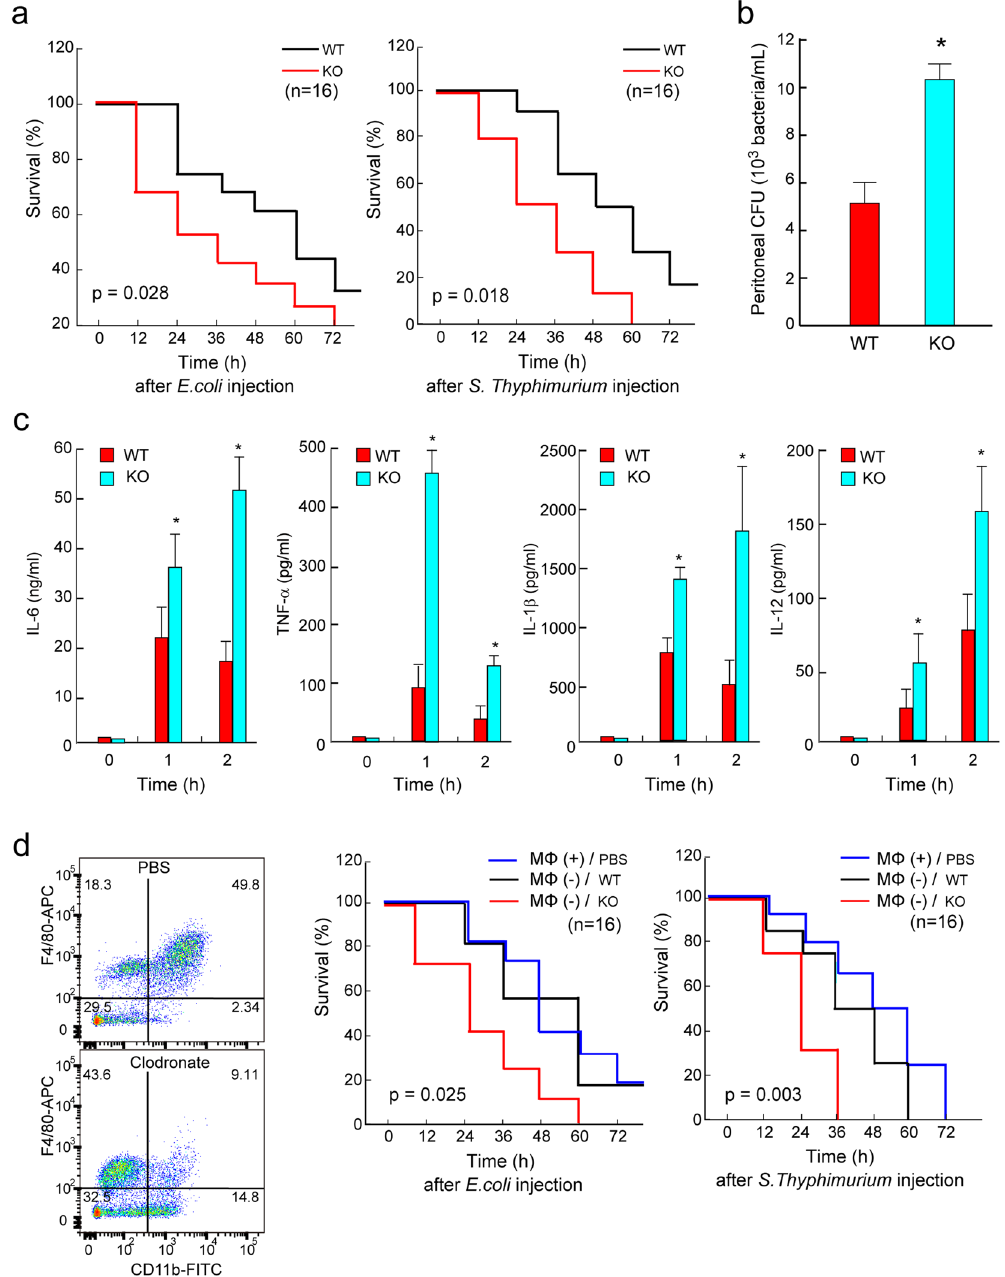
Figure 6. TAGLN2 participates in host survival after bacterial peritonitis. ( a ) TAGLN2 − / − mice demonstrate reduced survival after bacterial peritoneal sepsis. Age-, sex-, and weight-matched wild-type (black line) and TAGLN2 − / − (red line) mice were injected i.p. with 5 × 10 8 CFU of live E. coli (DH5 α ) or 5 × 10 6 CFU of live S. typhimurium . Kaplan-Meier survival curves revealing the proportion of mice that are alive in each group as a function of time from the first injection of bacteria are shown. ( b ) The E. coli cell count in peritoneal lavage fluid from wild-type or TAGLN2 − / − mice 4 h after i.p. administration of 10 8 CFU/mouse of E. coli is shown as bar graph ( n = 6). * P < 0.05 vs LPS-treated wild-type macrophages. ( c ) Cytokine (TNF- α , IL-1 β , IL-6, and IL-12) levels in plasma at 0, 1, and 2 h after i.p. injection of 5 × 10 6 CFU of live S. typhimurium into wild-type and TAGLN2 − / − mice. Data are the mean ± SEM; n = 8 per group. * i < 0.05 vs . wild-type mice at the same time point. ( d ) Flow cytometry plots of CD11b + , F4/80 + macrophages isolated from spleens at day 2 after clodronate liposomes treatment for depletion (n = 3 per group). Survival after transfer of wild-type and TAGLN2 − / − peritoneal macrophages in recipient wild-type mice with E. coli- or S. typhimurium -induced sepsis ( n =